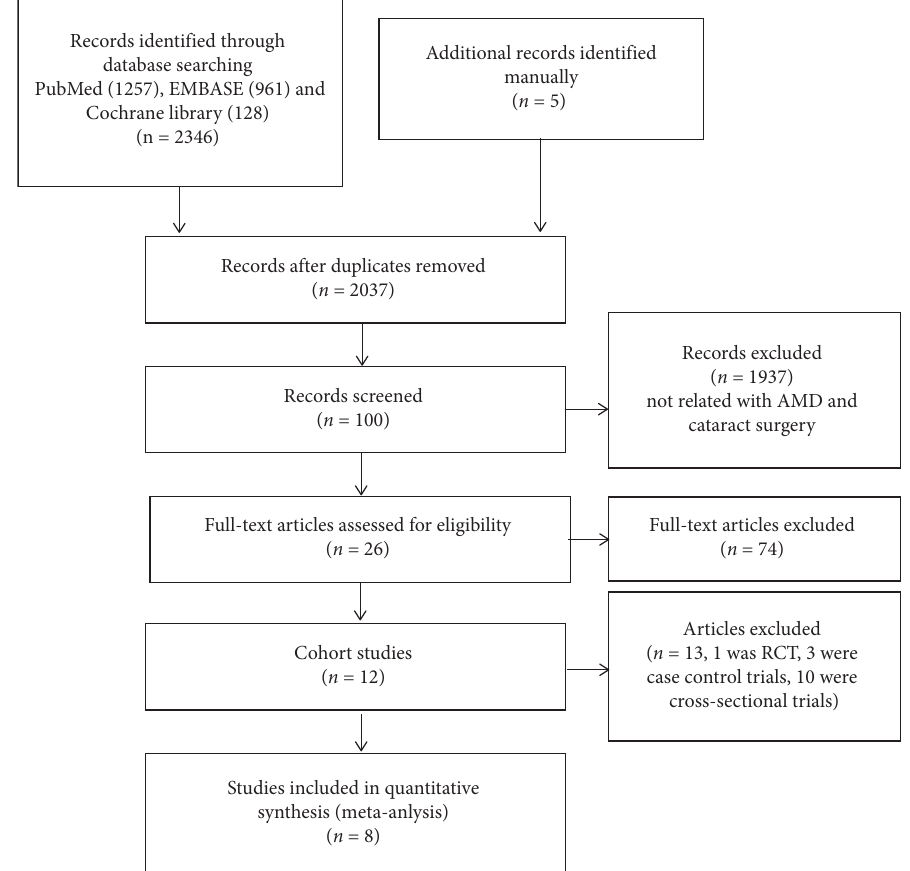
Figure 1: The trials selection